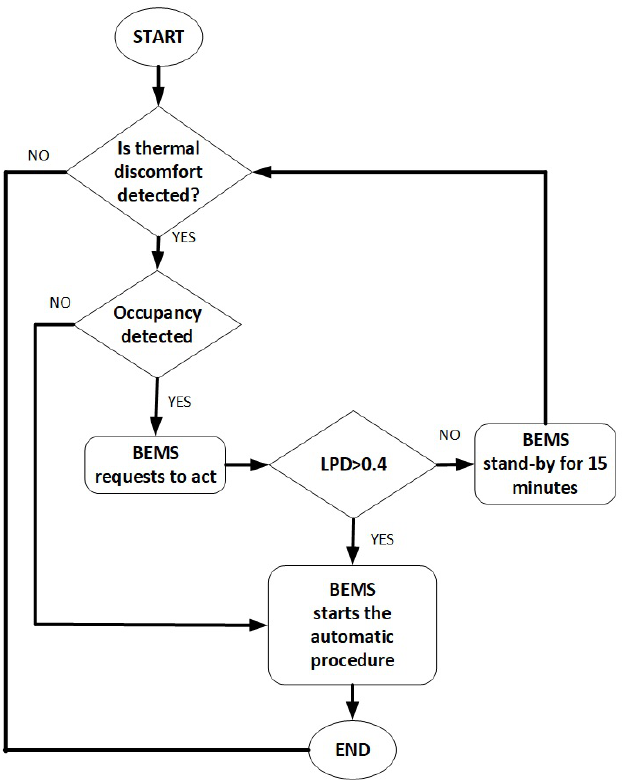
Figure 4. The Human–BEMS